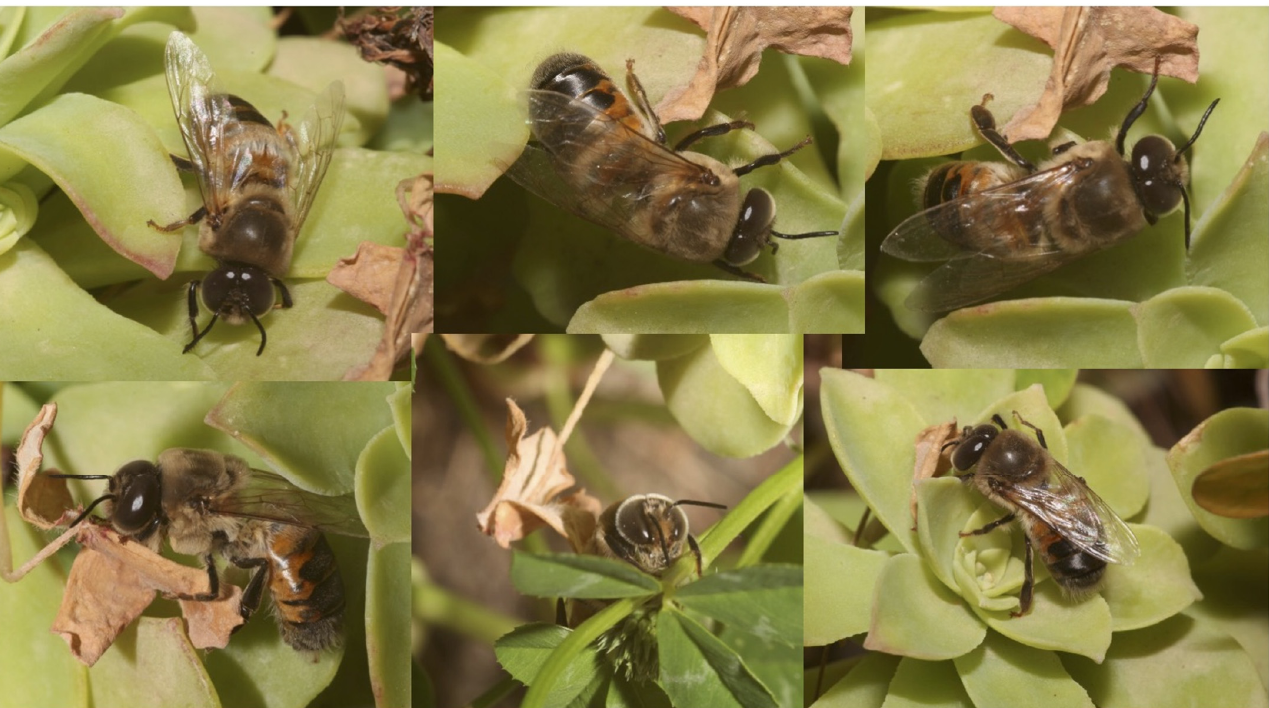
Figure 3. A honey bee drone ( Apis mellifera L.) on an Aeonium sp. plant (Crassulaceace) (Uri, Sardinia, Italy; photo: Pietro Niolu).